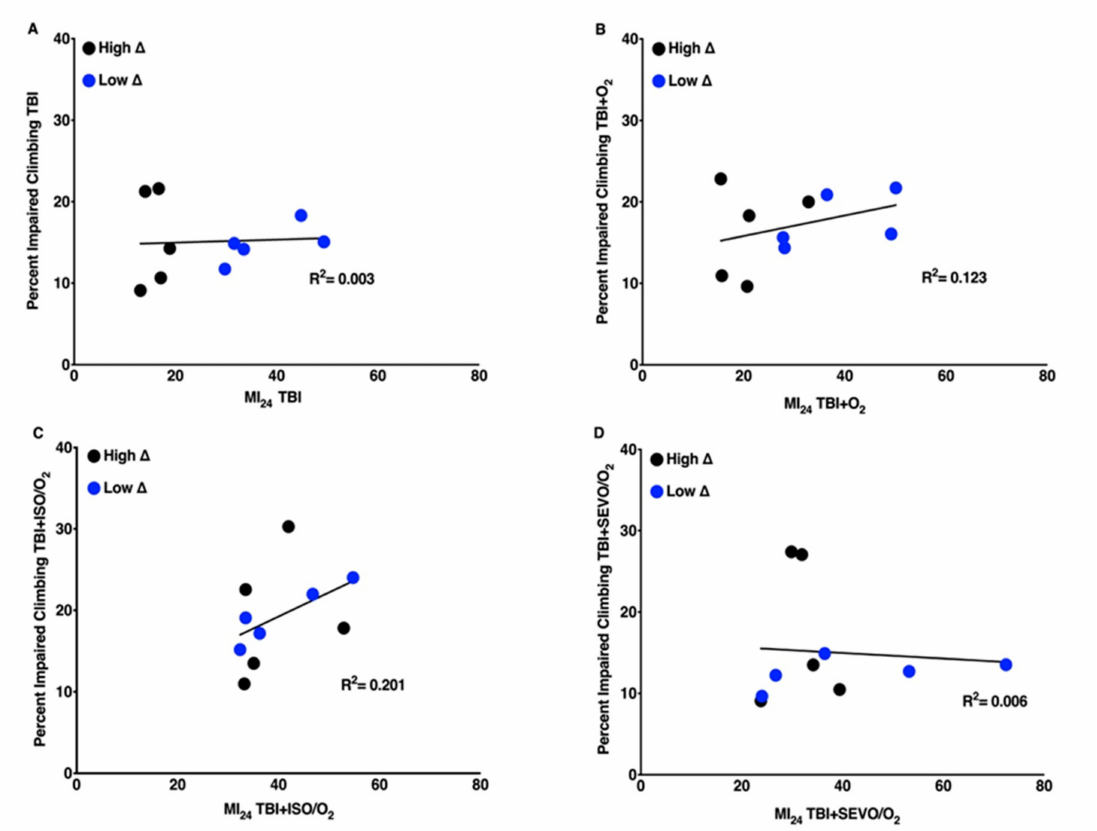
Figure 8. Percent impaired climbing and the MI 24 are not correlated following exposure to O 2 , ISO / O 2 , or SEVO / O 2 after TBI . Percent impaired climbing as a function of the MI 24 for ( A ) TBI, ( B ) TBI / O 2 , ( C ) TBI + ISO / O 2 , and ( D ) TBI + SEVO / O 2 . RAL lines in the high ∆ group are indicated by black dots and RAL lines in the low ∆ group are indicated by blue